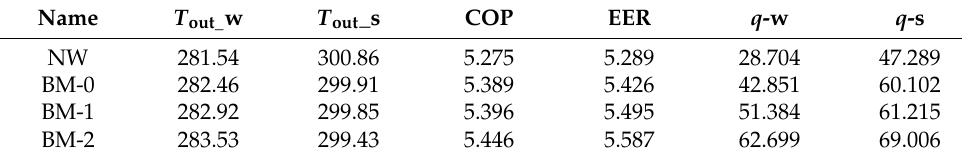
Table 5. Simulation and calculation